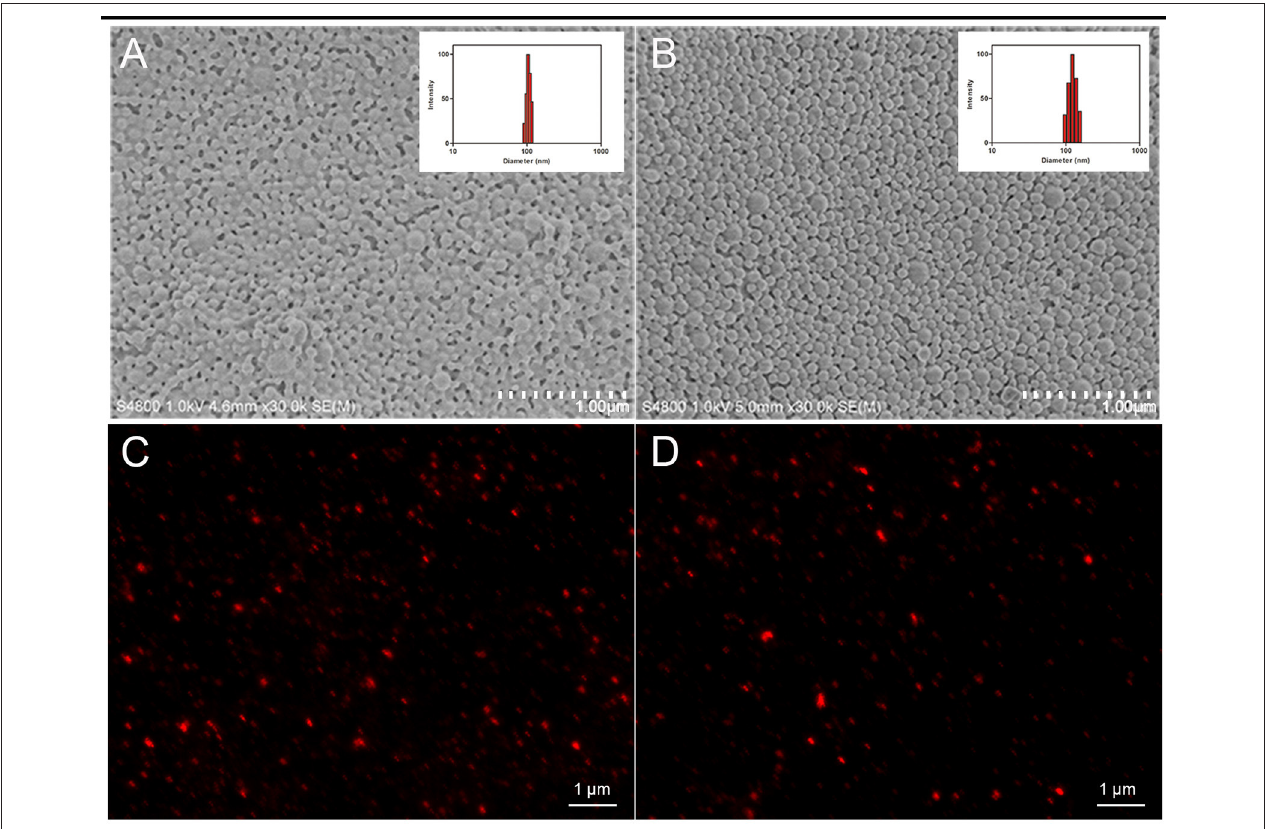
FIGURE 3 | Physical characteristics of HA-CMC-PLGA NPs and TF-HA-CMC-PLGA NPs. Scanning electron microscope images and dynamic lighting scattering measurements of HA-CMC-PLGA NPs (A) and TF-HA-CMC-PLGA NPs (B) ; Fluorescence images of HA-CMC-PLGA NPs (C) and TF-HA-CMC-PLGA NPs (D) . Scale bar = 1 µ